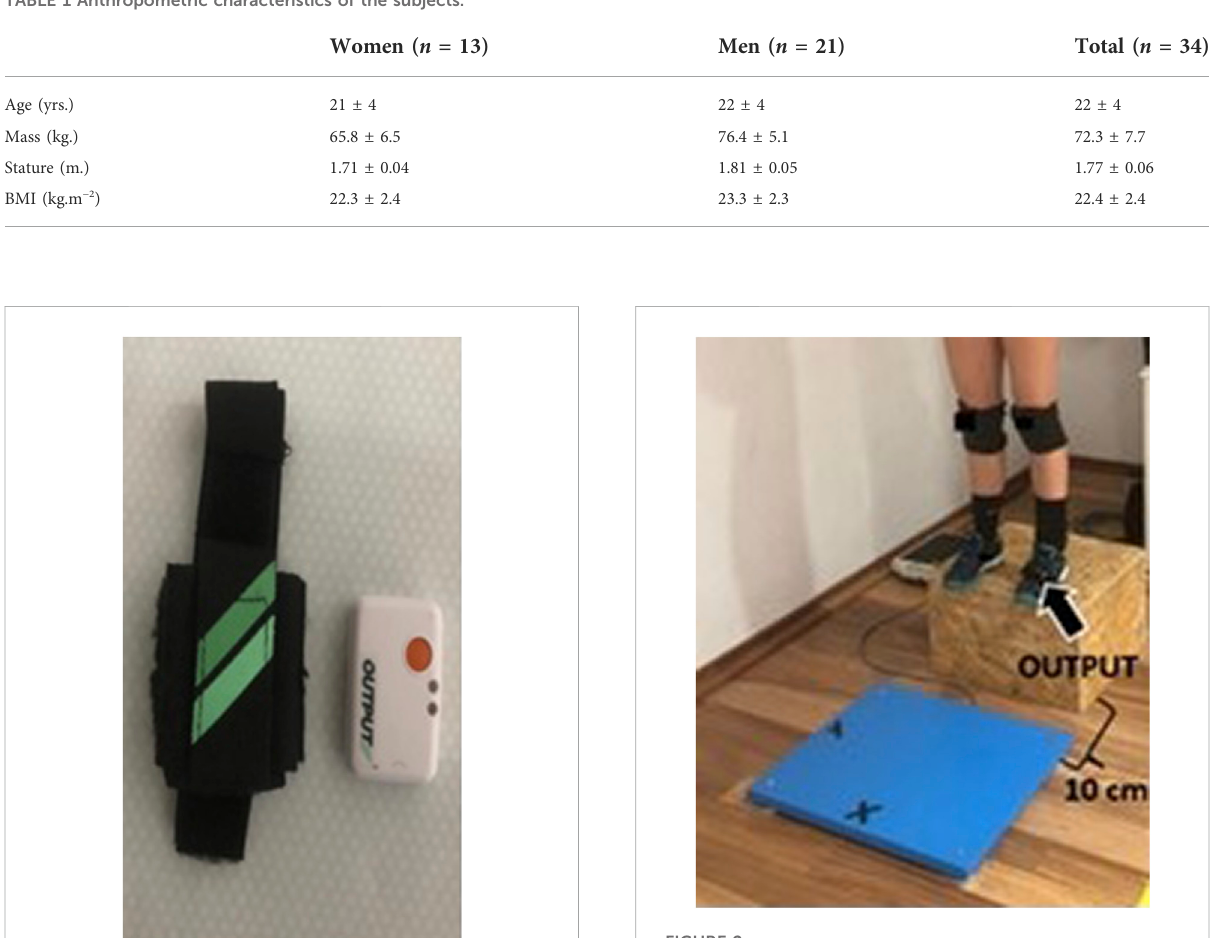
FIGURE 2 Placement of the OUTPUT mobile inertial unit on the left